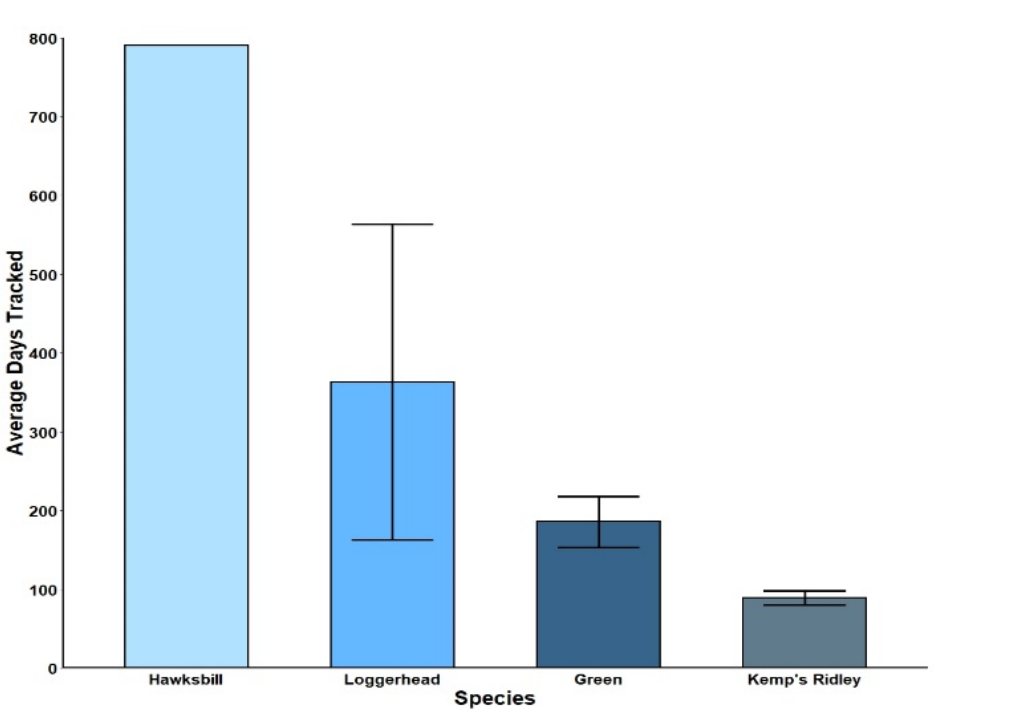
Figure 1. Average number of days tracked using mean number of state–space model (SSM) points per individual by species. Error bars represent standard error. Sample sizes are as follows: Hawksbill = 1, Loggerhead = 8, Green = 25, Kemp’s Ridley = 6.